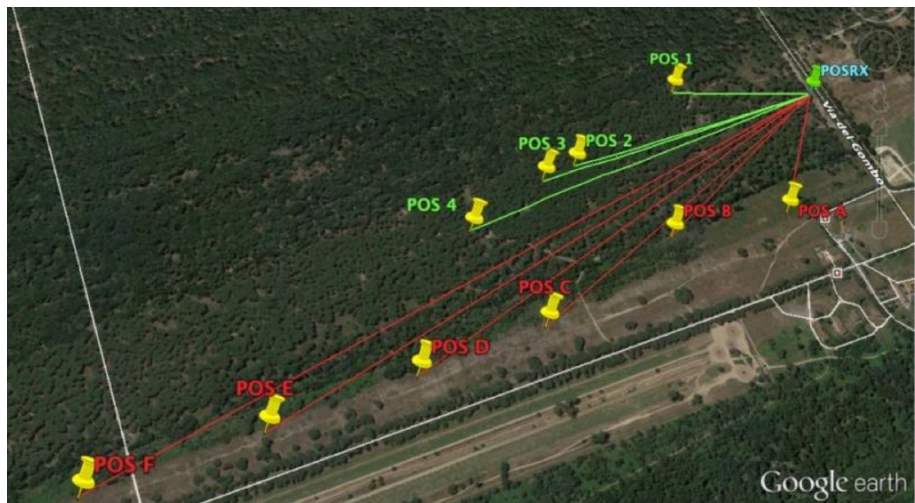
Figure 7. The Prototype devices (LoRa end-node) placed at different positions (POS A–POS F, POS 1–POS 4), and the Gateway indicated as POSRX.